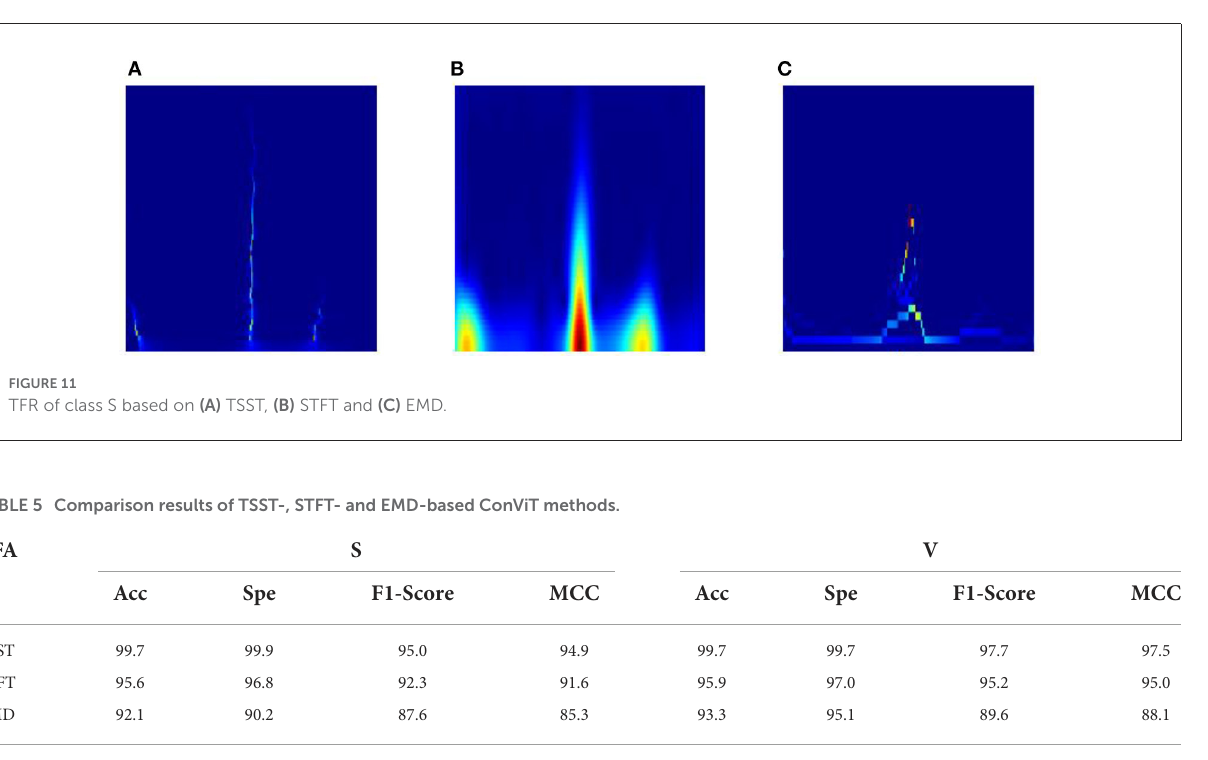
algorithm, traditionally used for 2-D image